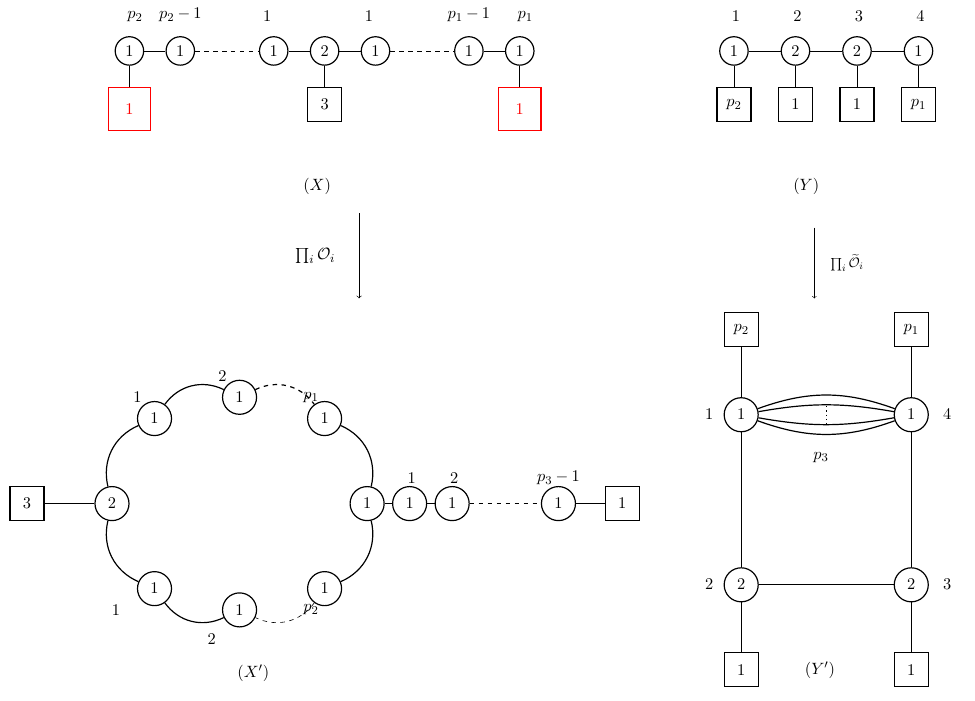
Figure 25 . The quiver ( X 0 ) and its mirror dual ( Y 0 ) in figure 23 is generated by a sequence of elementary S -type operations on different nodes. In each step, the flavor node(s) on which the S -type operation acts is shown in